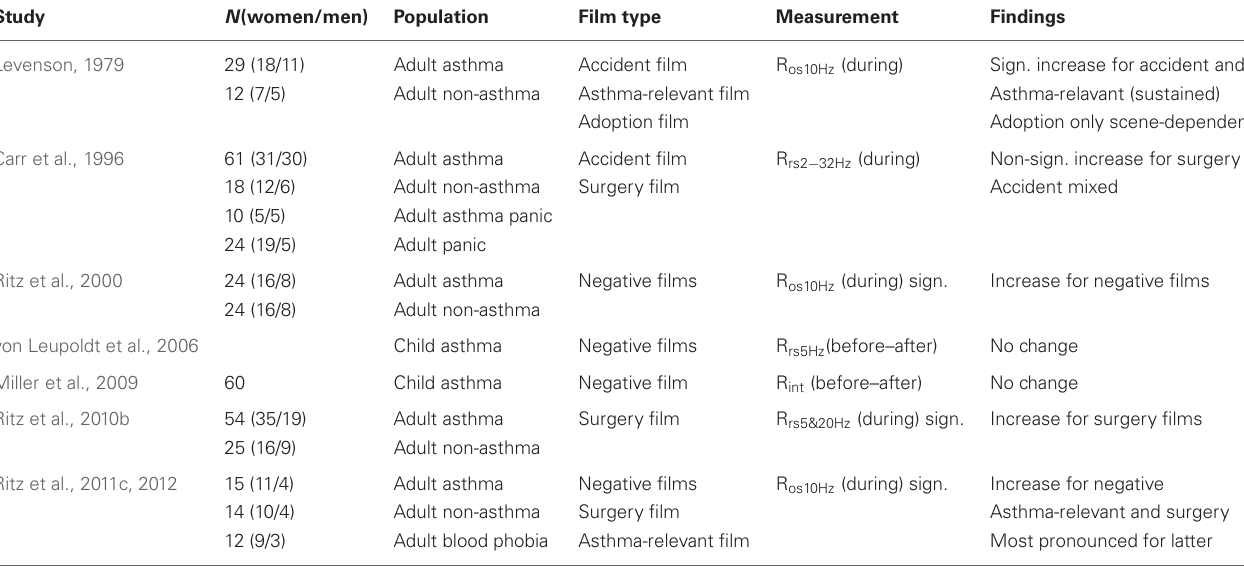
Table 2 | Studies exploring effects of negative emotional film presentation on respiratory resistance.